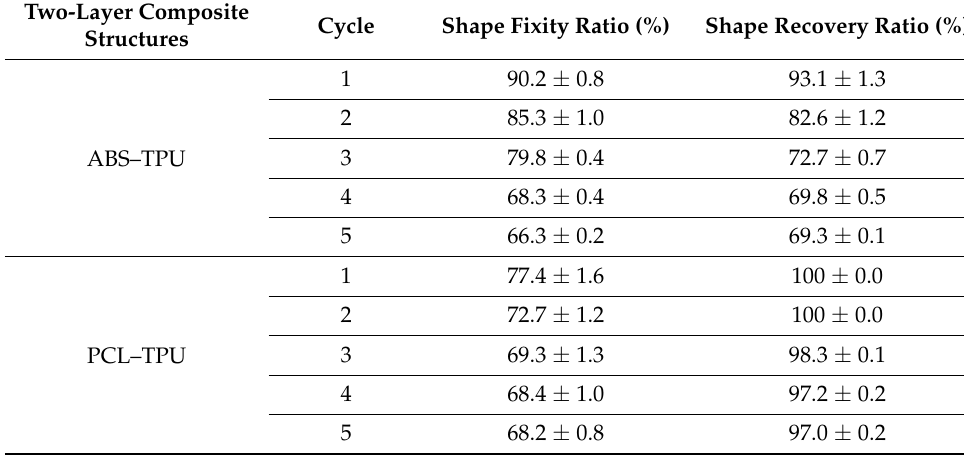
Figure 7. Shape memory properties in the last shape memory cycle: ( a ) fixity and ( b ) recovery for the ABS–TPU composite, and ( c ) fixity and ( d ) recovery for the PCL–TPU composite.